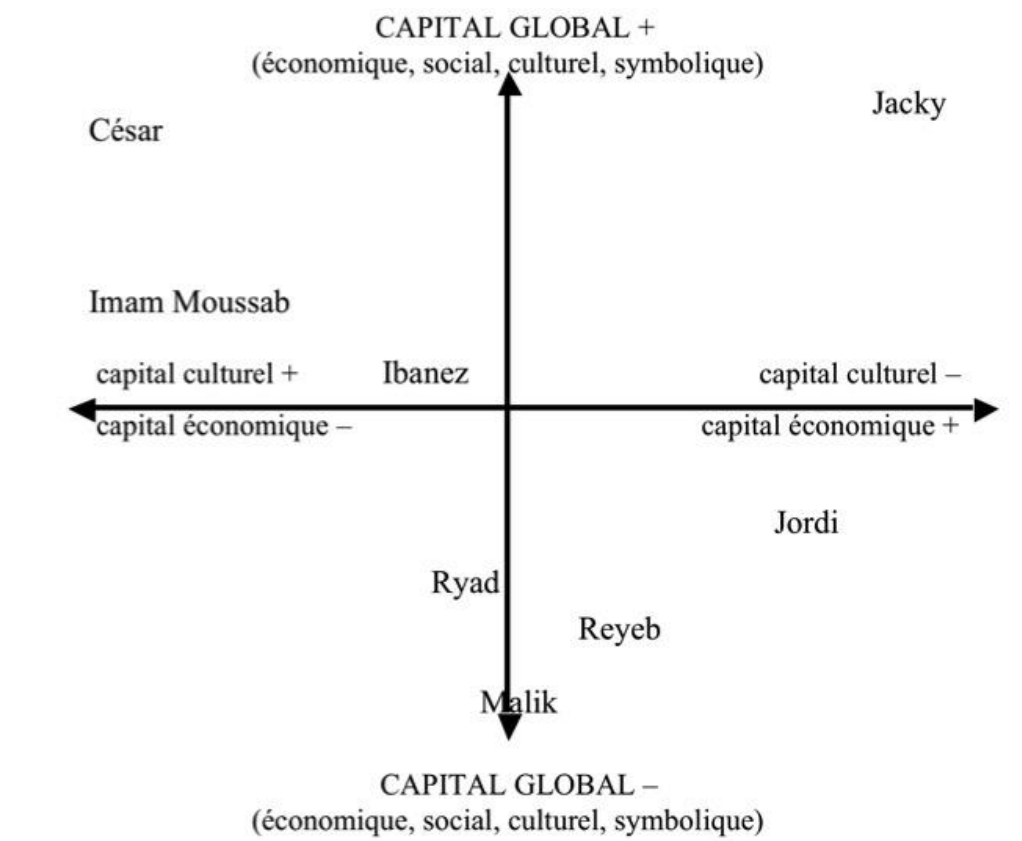
Figure 1 Espace initial des posit ions sociales des personnages d’ Un